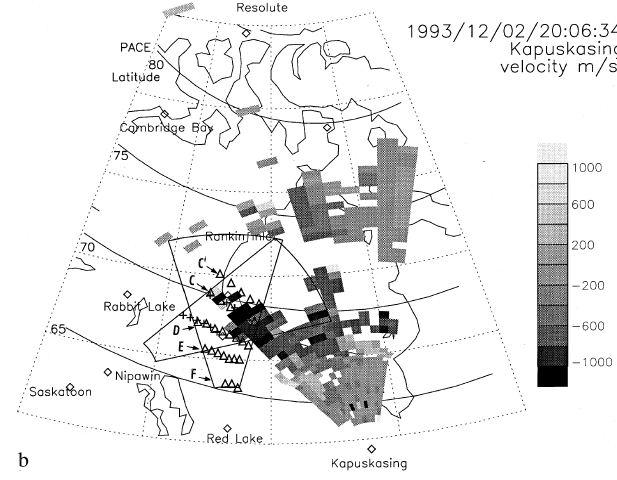
of view indicate the position of the latter band. b Another FCE associated with the E-region backscatter band